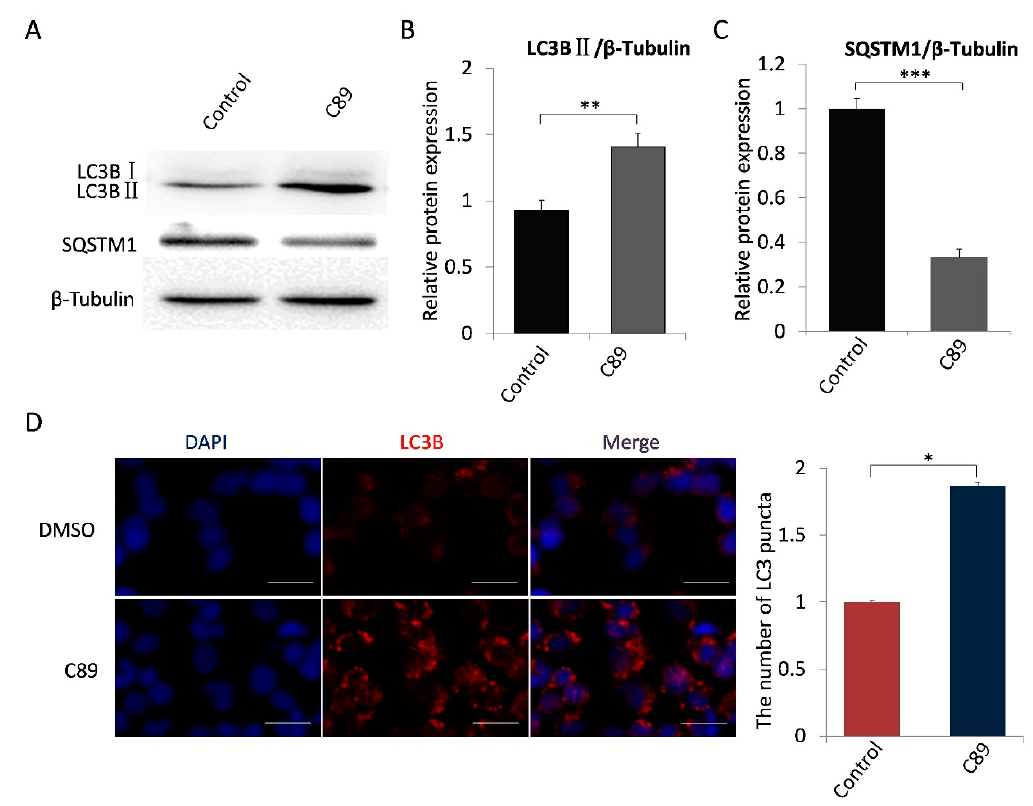
Figure 2. C89 induces autophagy in FGSCs in vitro. ( A – C ) Western blot analysis of autophagy marker proteins LC3BII and SQSTM1 in FGSCs treated with C89 or controls. LC3BII expression was significantly higher in C89-treated groups than in control groups ( B ) ( p < 0.01), and SQSTM1 expression was significantly lower in C89-treated groups than in control groups ( C ) (p < 0.001). ( D ) Immunofluorescence assay of LC3B puncta in C89-treated FGSCs. The number of LC3B puncta per cell in C89-treated groups was significantly higher than in control groups ( p < 0.01). * p <